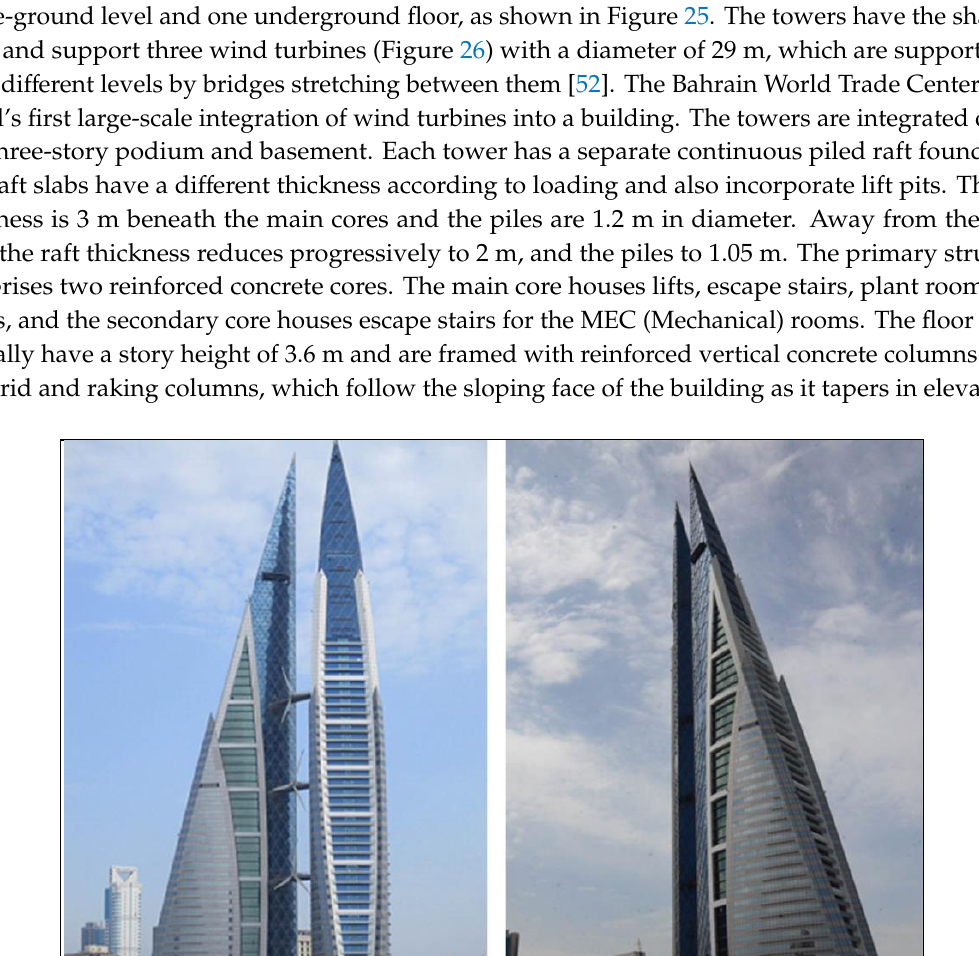
Figure 25. Bahrain World Trade Center: Floor plan and section (developed by authors on the basis of [54]).